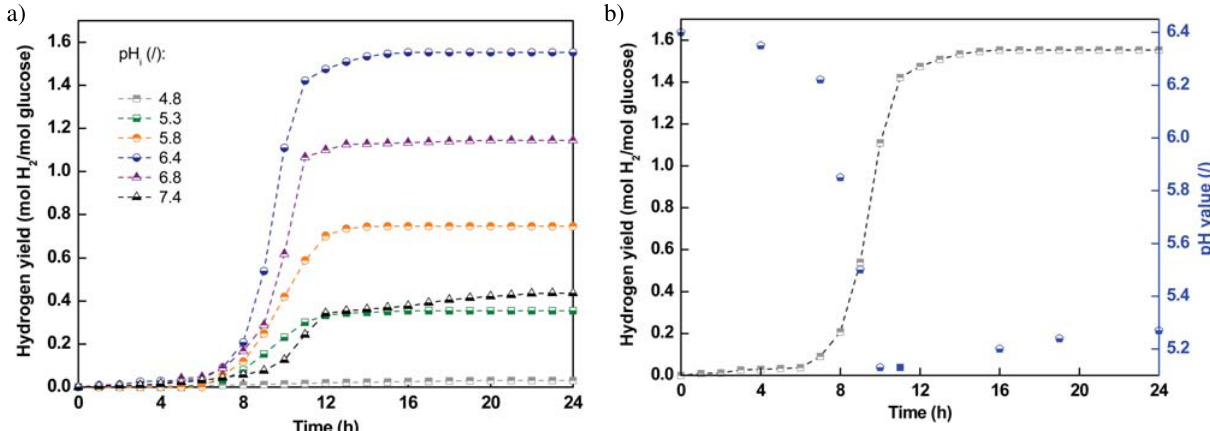
Figure 1. Effect of different initial pH values of fermentation broth on hydrogen yield (a) and change of pH value during hydrogen production (b). Lines show